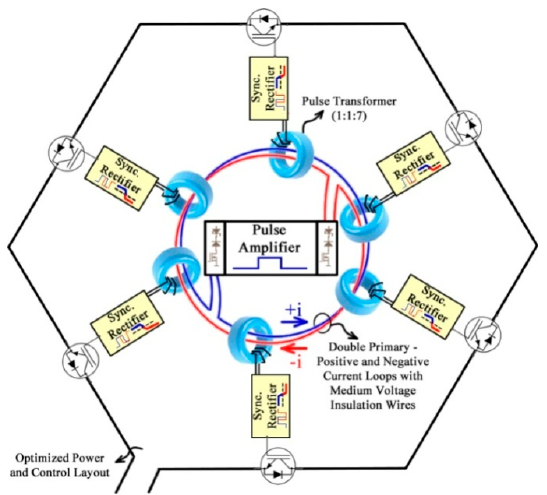
Figure 5. Schematic of the firing circuit with a synchronous rectifier, two primary simple magnetic loops, based on the thyristor firing concept.